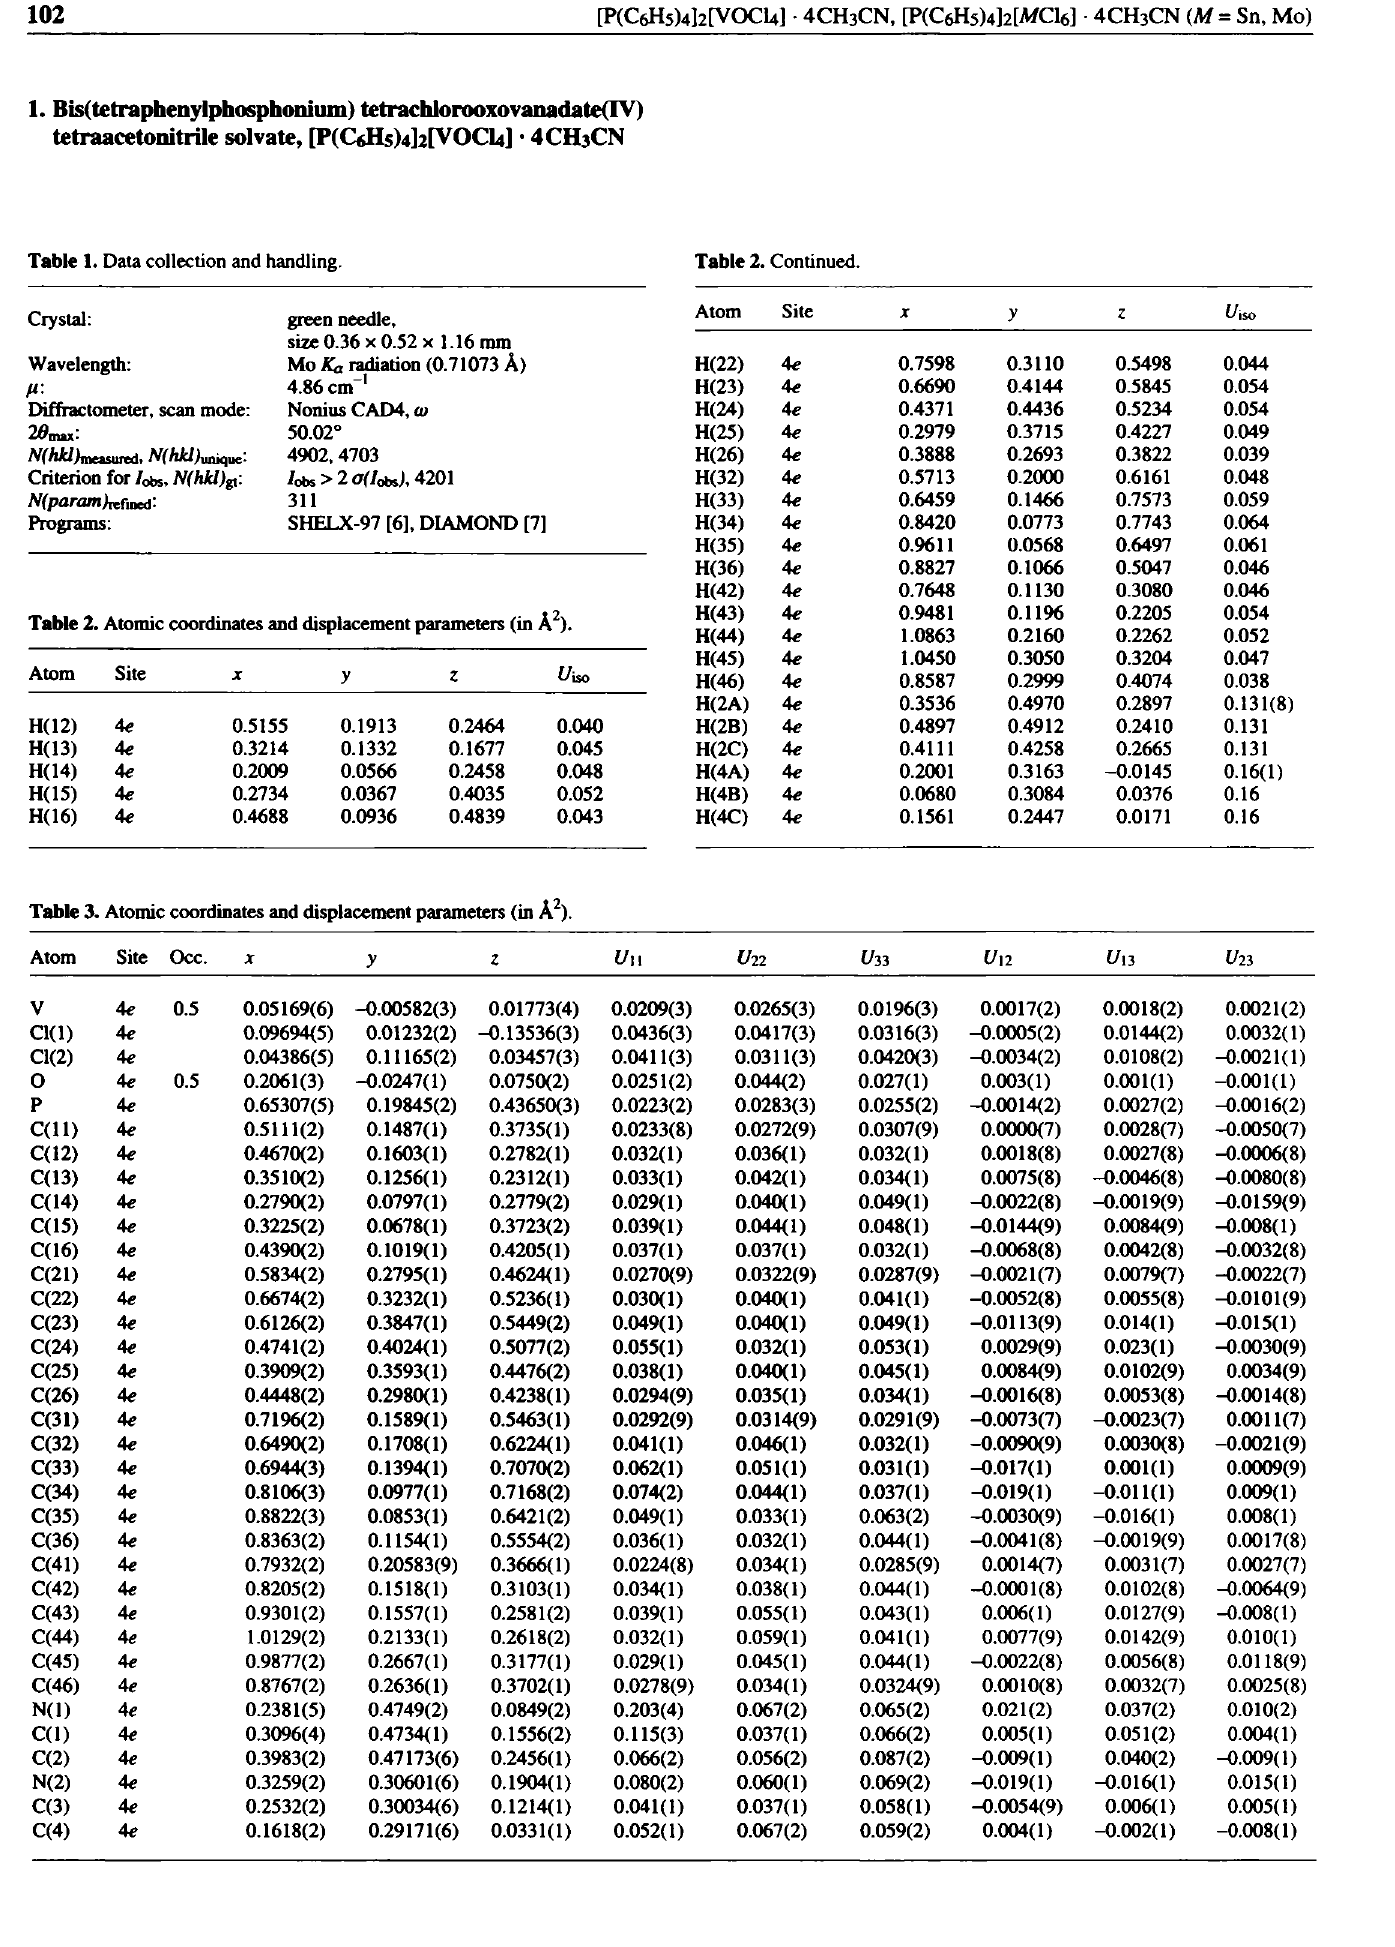
Table 1. Data collection and handling.